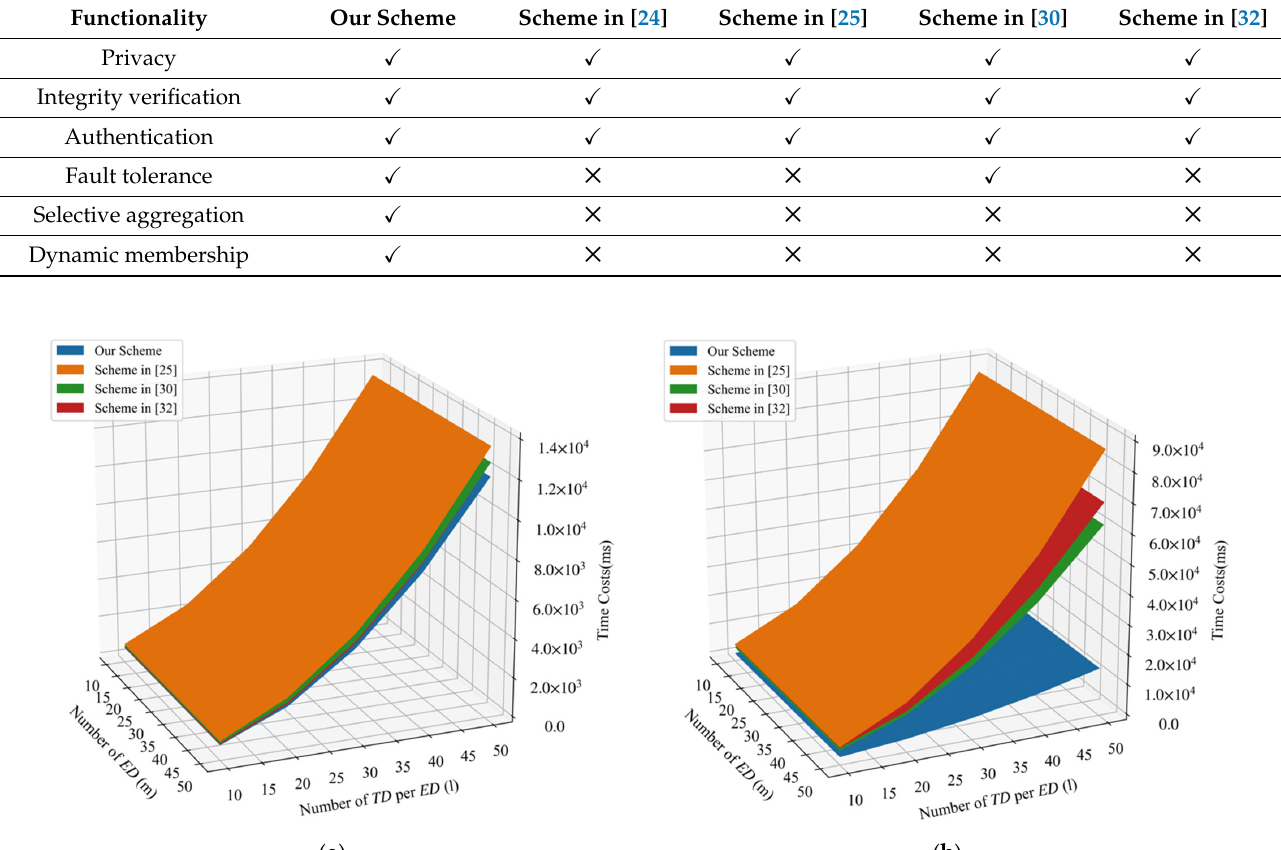
Figure 4. ( a ) Comparison of aggregation costs. ( b ) Comparison of signature and verification costs.